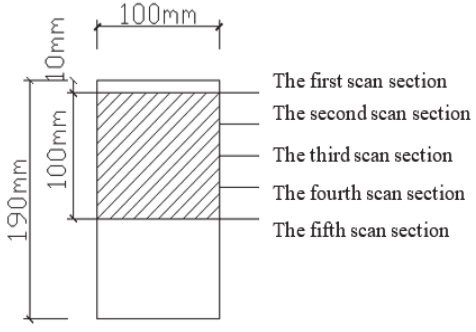
Figure 3: Concrete sections map of CT scan.